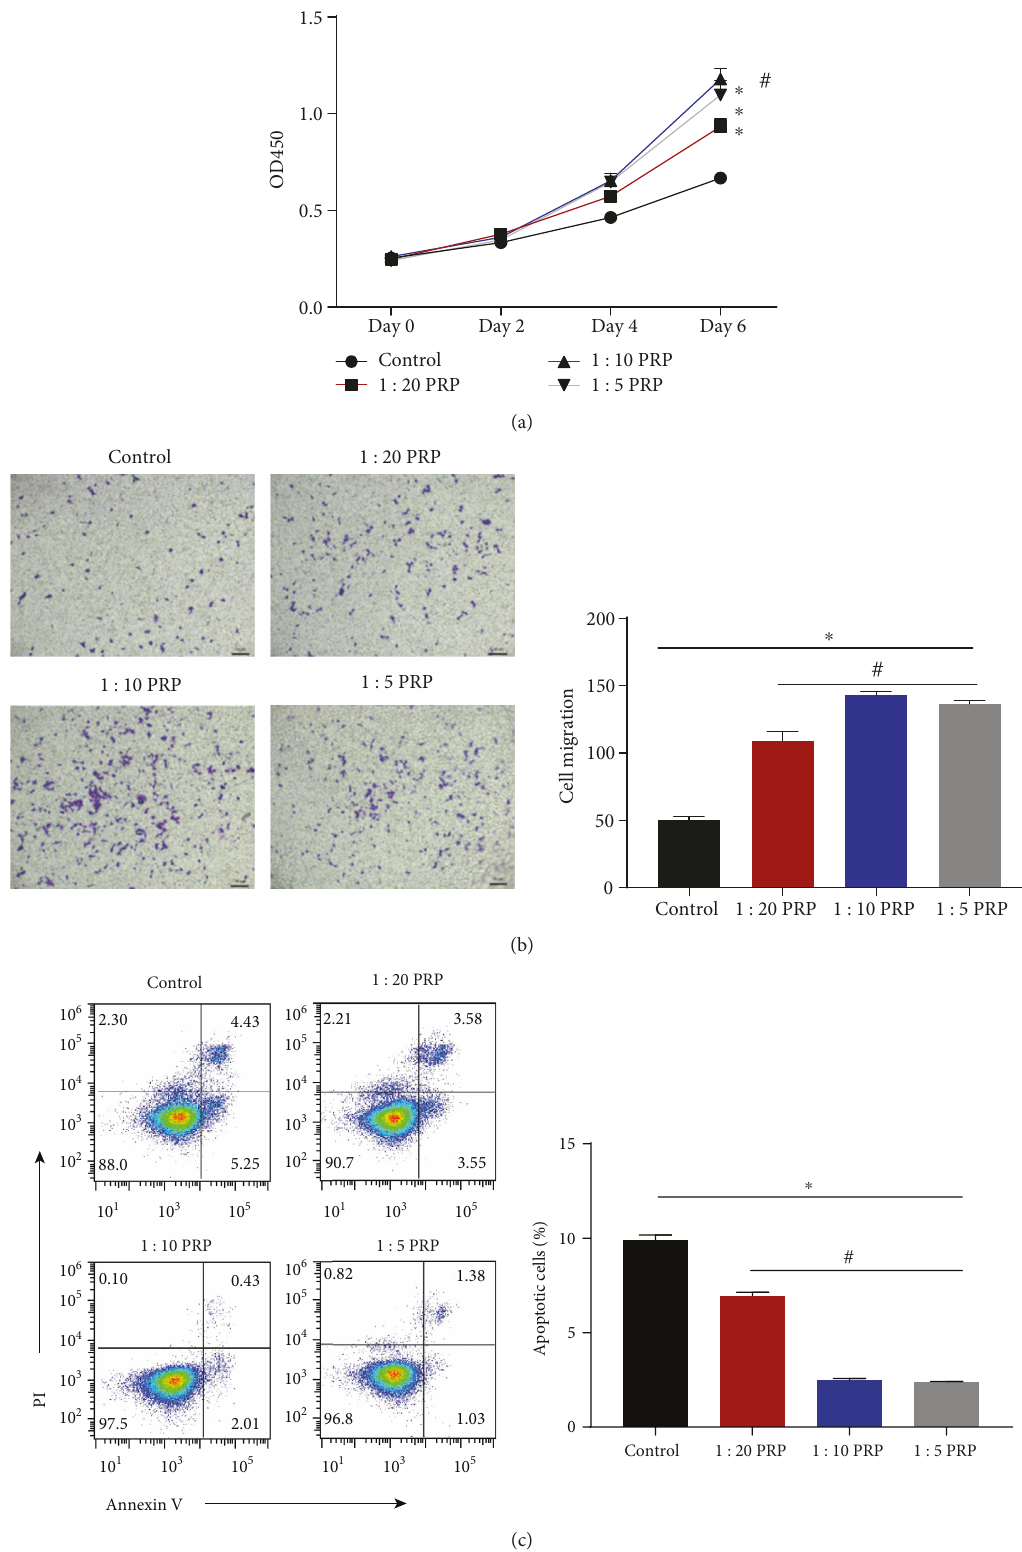
Figure 1: EPC apoptosis, proliferation, and migration in each group. (a) EPC proliferation in each group at days 0, 2, 4, and 6 is shown as the OD450 value. (b) EPC migration assay. The number of migrating EPCs was analyzed and is shown as a bar chart. (c) The percentage of apoptotic EPCs is shown as a bar chart. ∗ p < 0 05 for the treatment group vs. the control group and # p < 0 05 for the 1 :10 PRP group vs. the other concentration